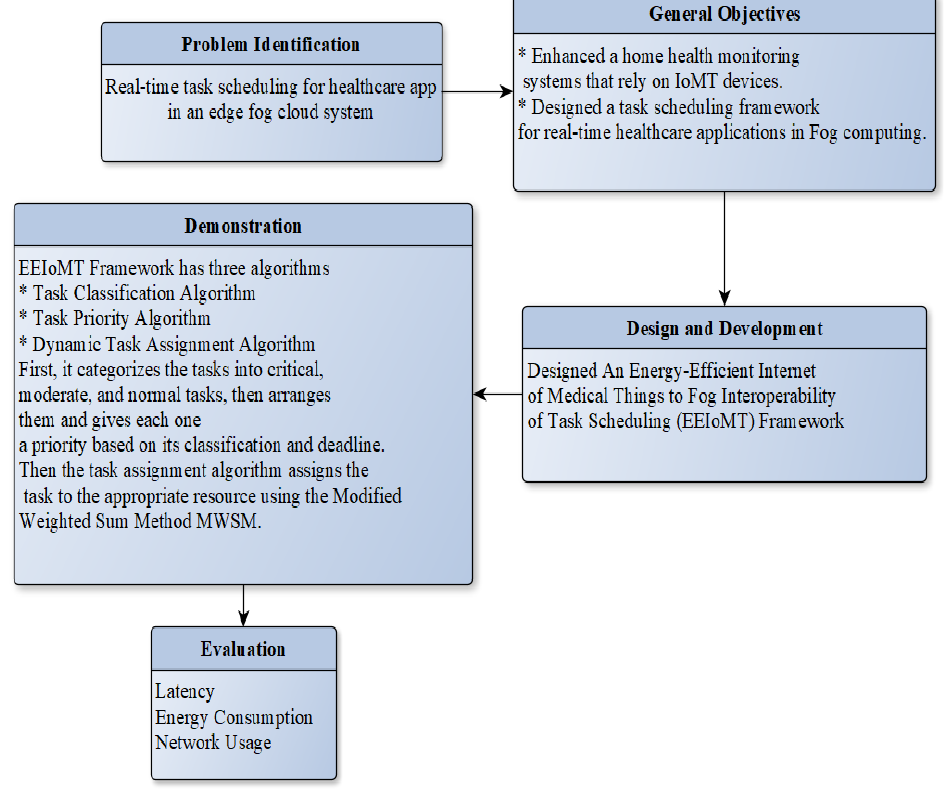
Figure 1. Research